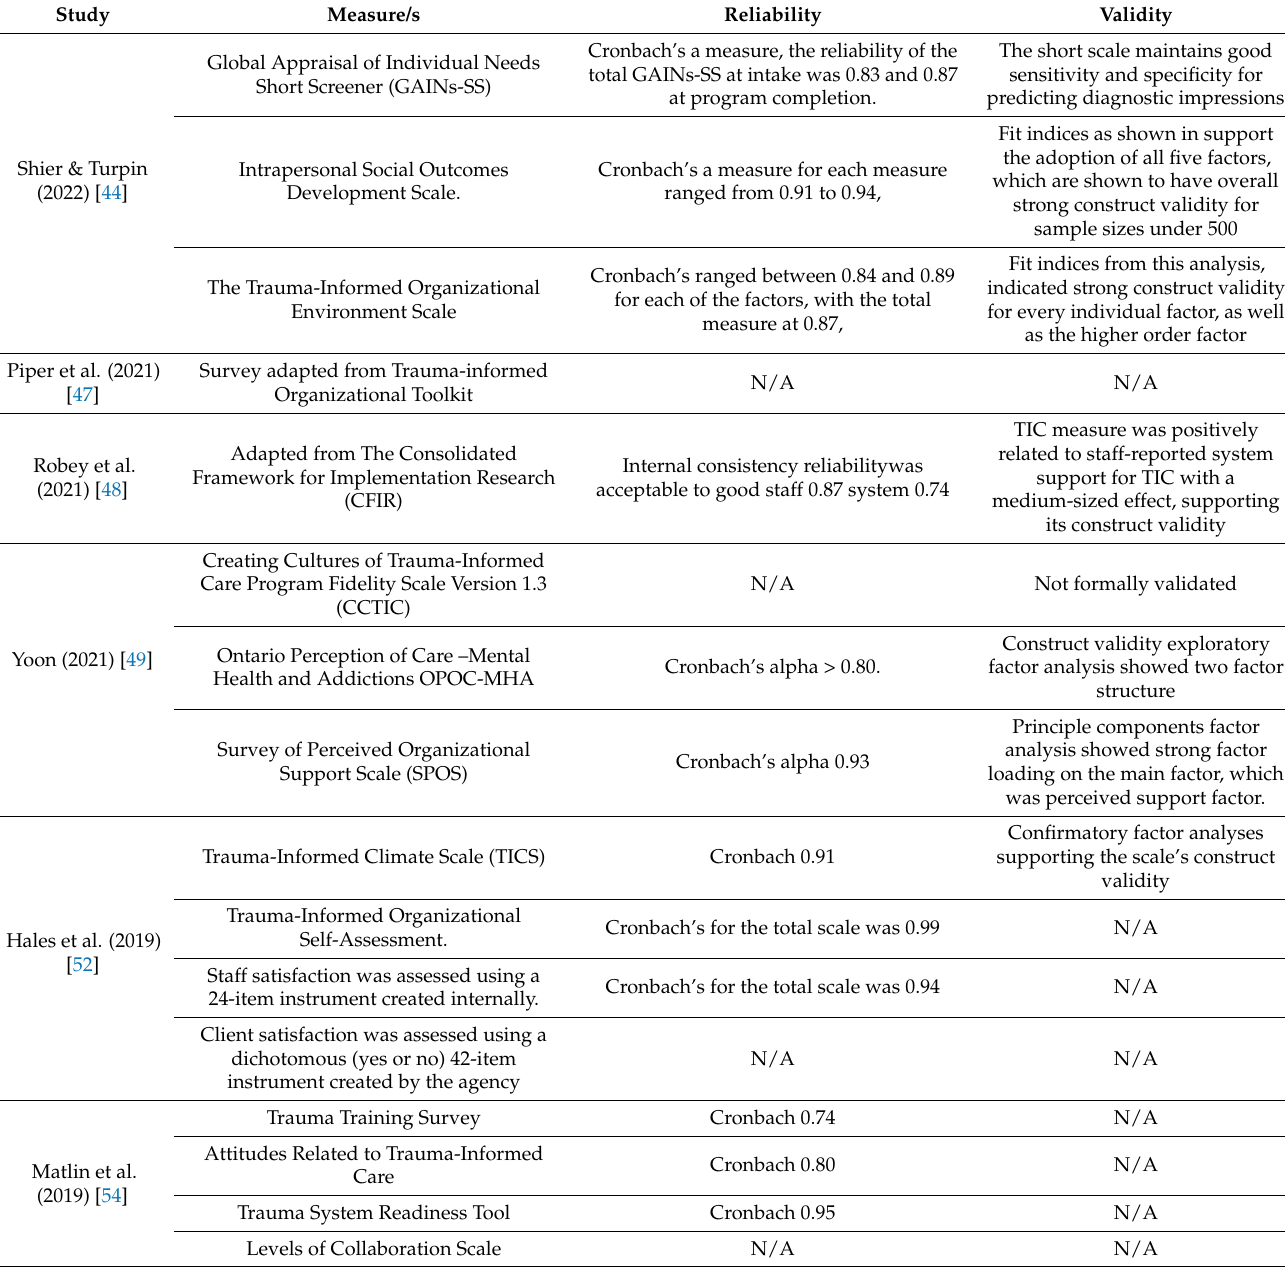
Table 3. Psychometric properties of included